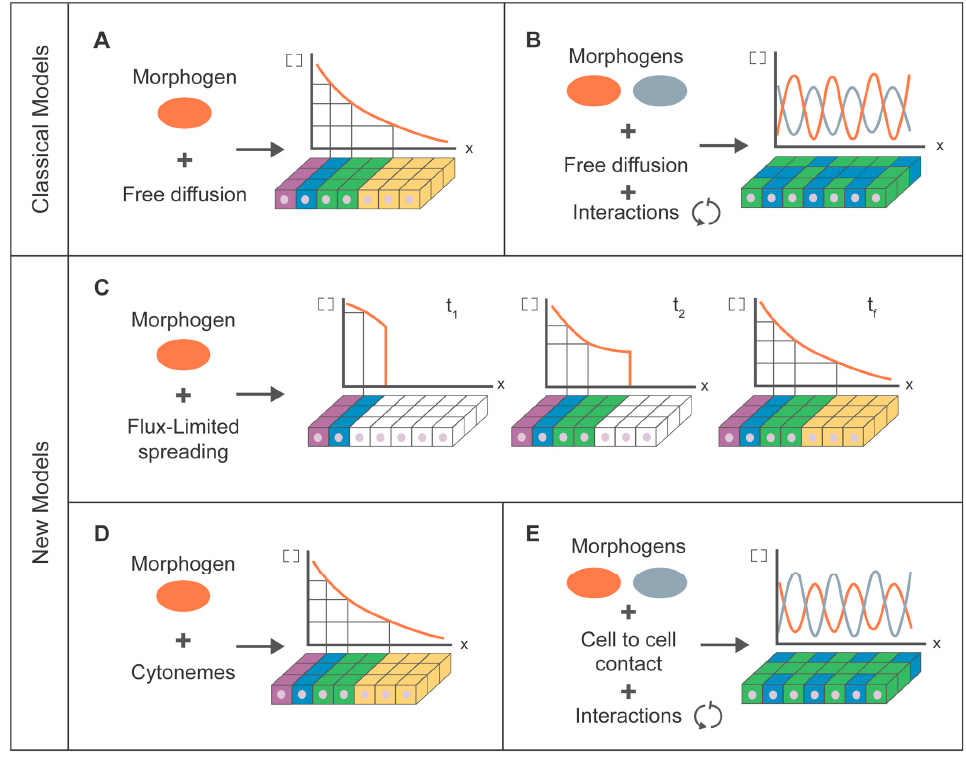
Figure 2. Schematic representation of the main similarities and differences between the mathematical frameworks of molecular signaling. ( A ) Classical view of a signaling gradient through free diffusion equation (positional information theory) [118]; ( B ) Turing model, taking into account the free diffusion of two morphogens and the interactions between them [119]; ( C ) Evolution of the gradient states at different times (t 1 ,t 2 ) until the final state (t f ) under the flux-limited spreading model, considering a nonlinear mechanism of transport (speed limitation) due to the properties of biochemical molecules do not allow them to move freely [127]; ( D ) Theoretical approximation to a specific biological mechanism (cytonemes) to explain the experimental gradient shown in C [128]; ( E ) Signaling model through cell-to-cell contact and interaction between morphogens to explain pattern formation